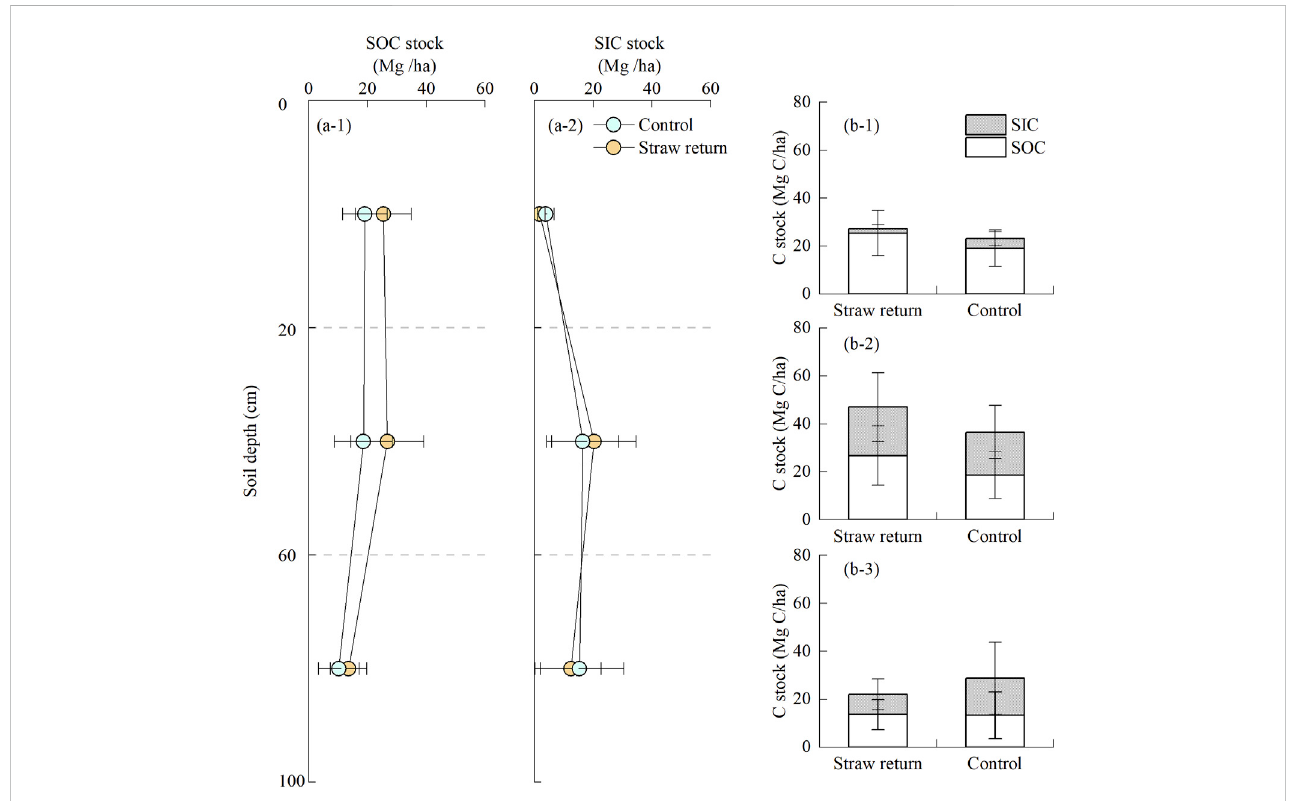
FIGURE 2 Vertical distribution of SOC and SIC stock in straw return (a-1) and control (a-2) scenarios; SOC and SIC stock in the surface (b-1) , subsoil (b-2) , and under-subsoil (b-3) layers. Bars indicate mean ± SD values ( n =